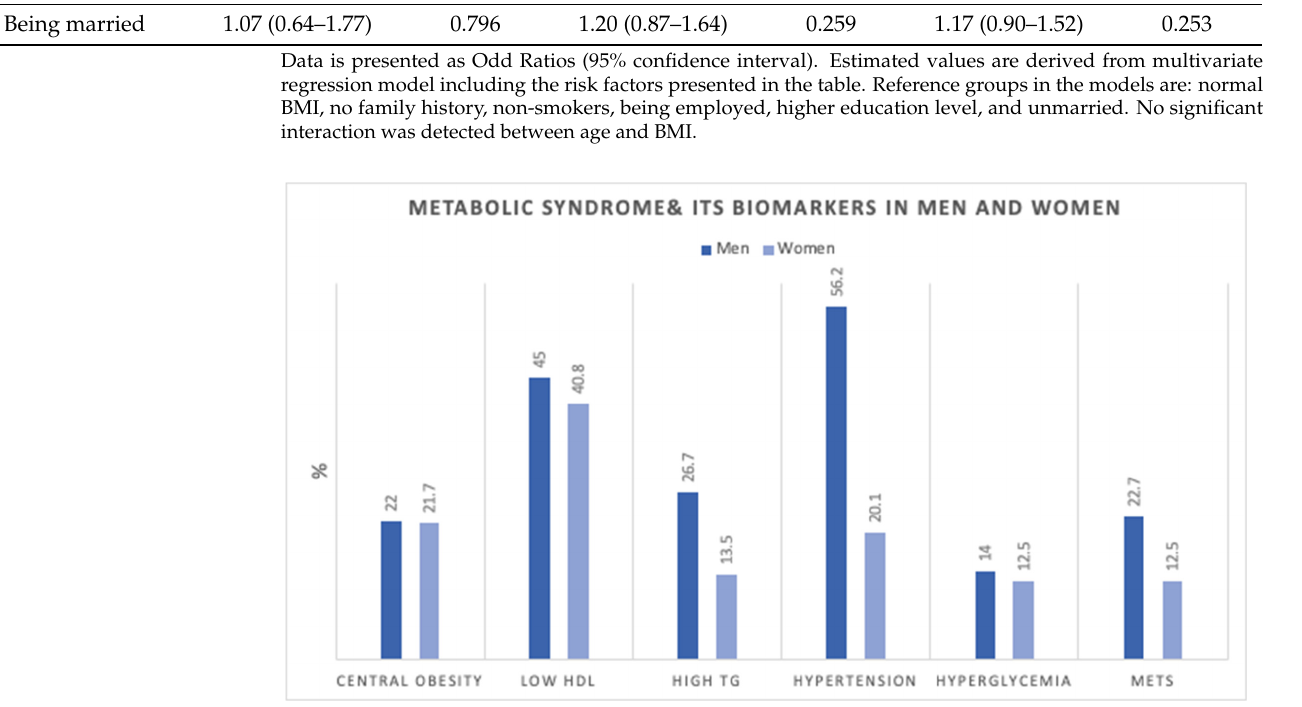
Figure 1. Age ‐ adjusted Prevalence (%) of metabolic syndrome components in men ( n = 3196) and women ( n = 19,651). HDL; high ‐ density lipoprotein, TG; triglycerides, MetS; Metabolic Syndrome.